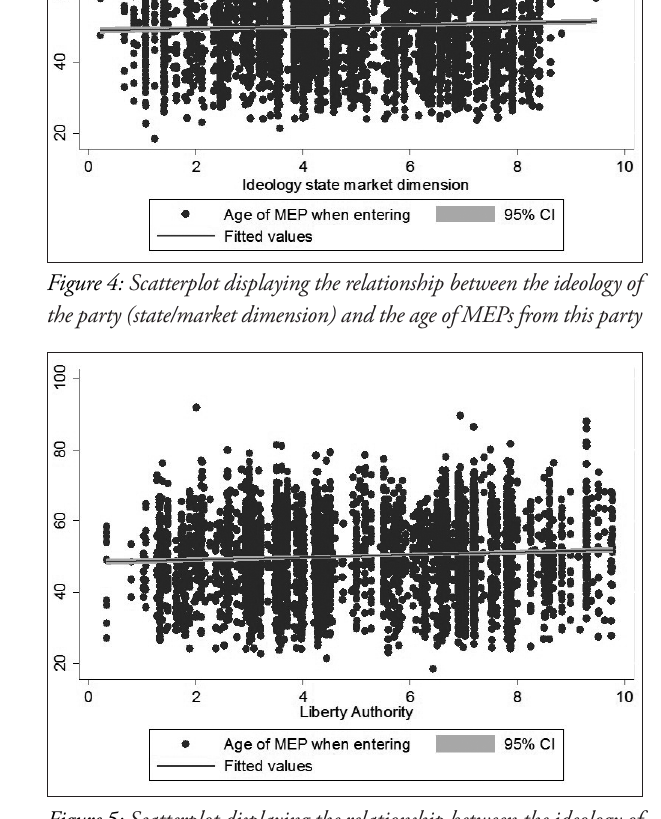
Figure 2: Scatterplot displaying the relationship between the age of the party and the age of MEPs from this party